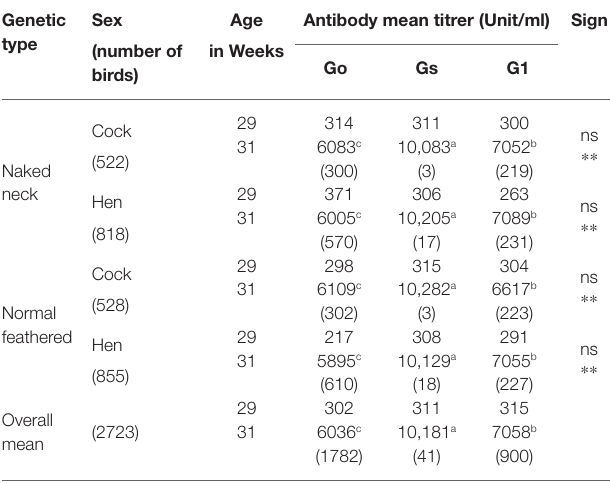
TABLE 1 | Antibody mean titer of parents, selected parents, and their offspring according to genetic types, sex, and age. Genetic type